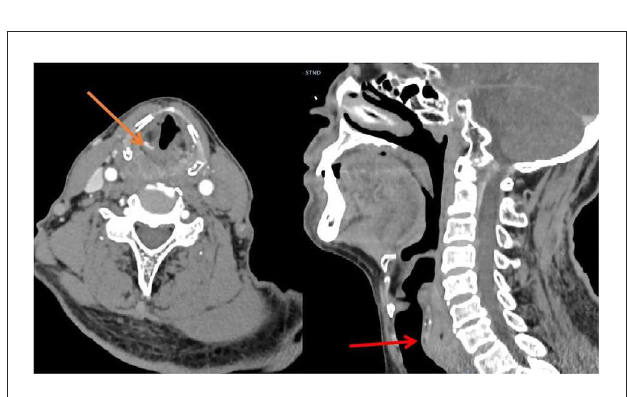
FIGURE3 CT showed upper esophageal cancer with diffuse thickening and calcification.